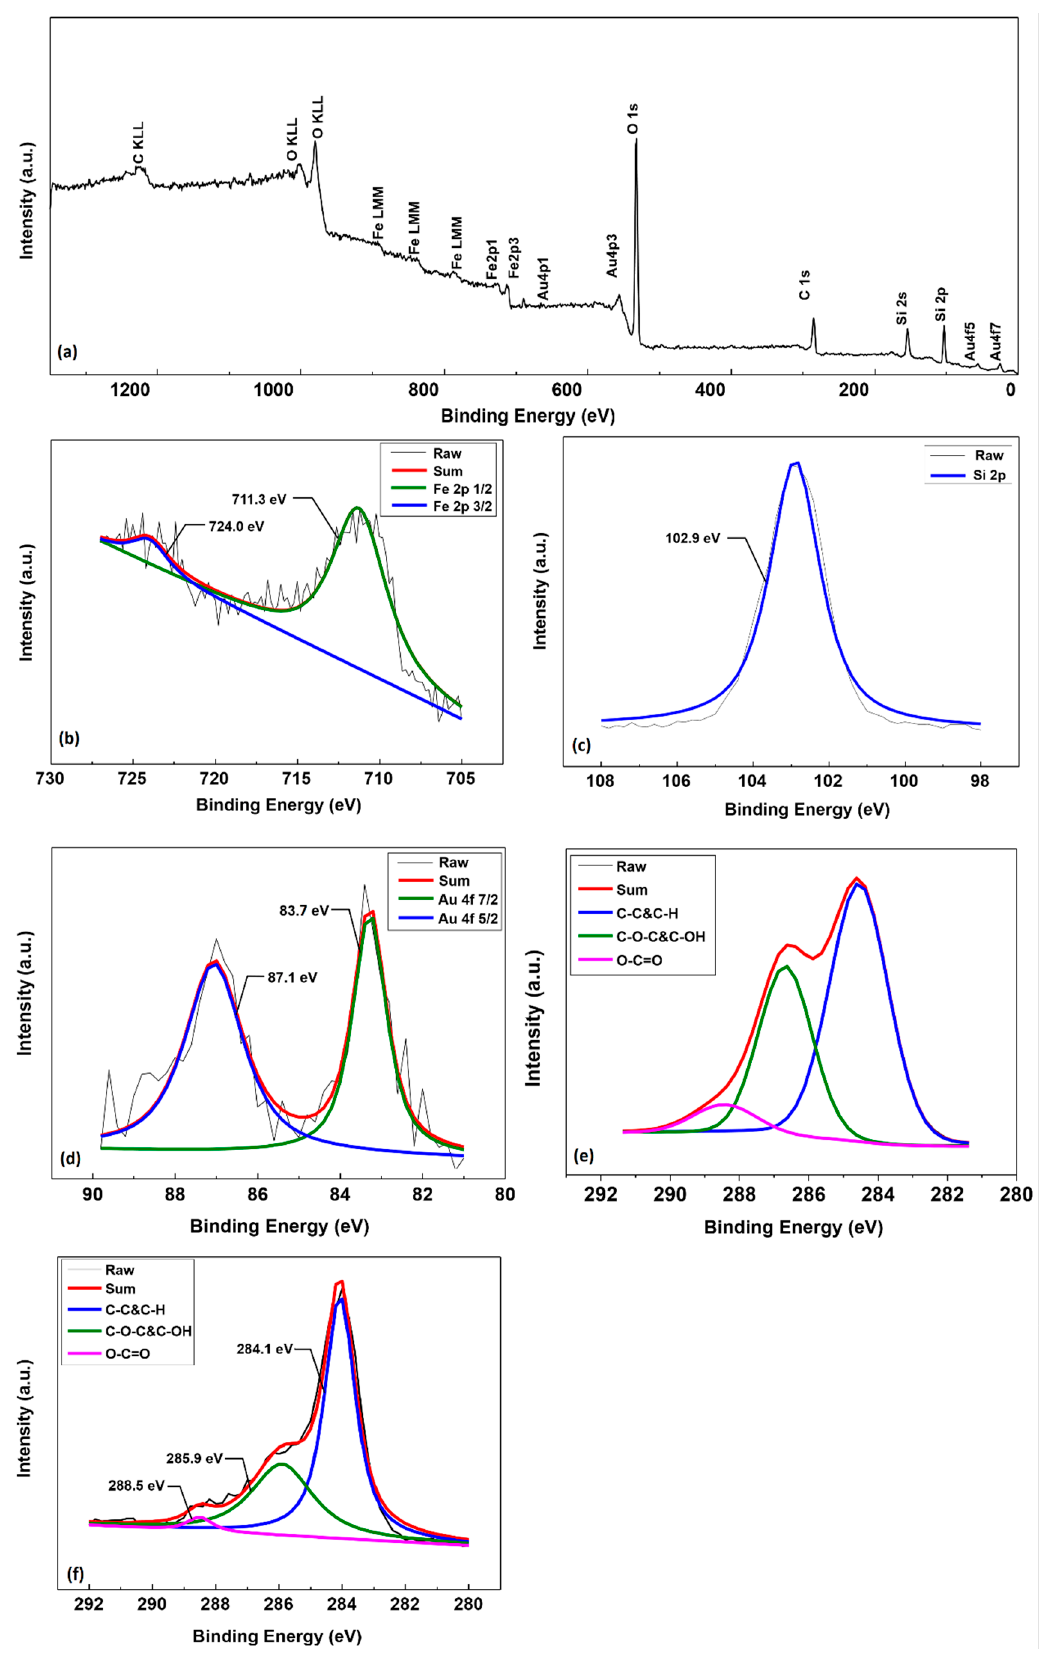
Figure 3. ( a ) Full range XPS spectrum of Au-SiO 2 @Fe 3 O 4 -RGO, ( b ) Fe 2p, ( c ) Si 2p, and ( d ) Au 4f XPS spectra of Au-SiO 2 @Fe 3 O 4 -RGO; C 1s XPS spectra of ( e ) GO and ( f ) Au-SiO 2 @Fe 3 O 4 -RGO.